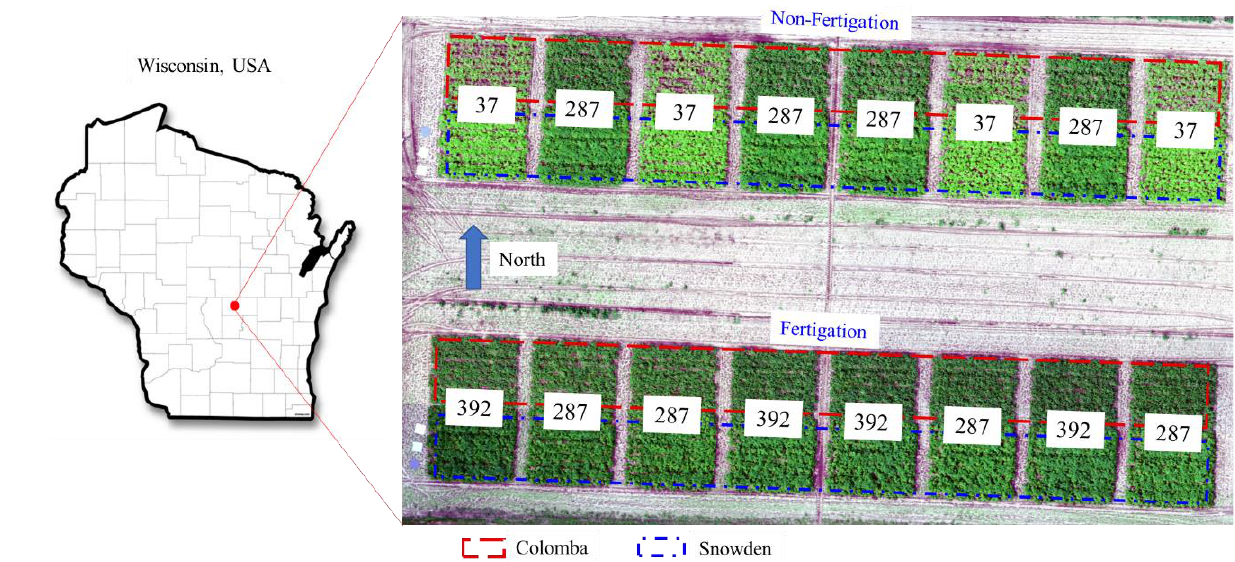
Figure 1. Experimental site and design. Table 1. Nitrogen treatments and